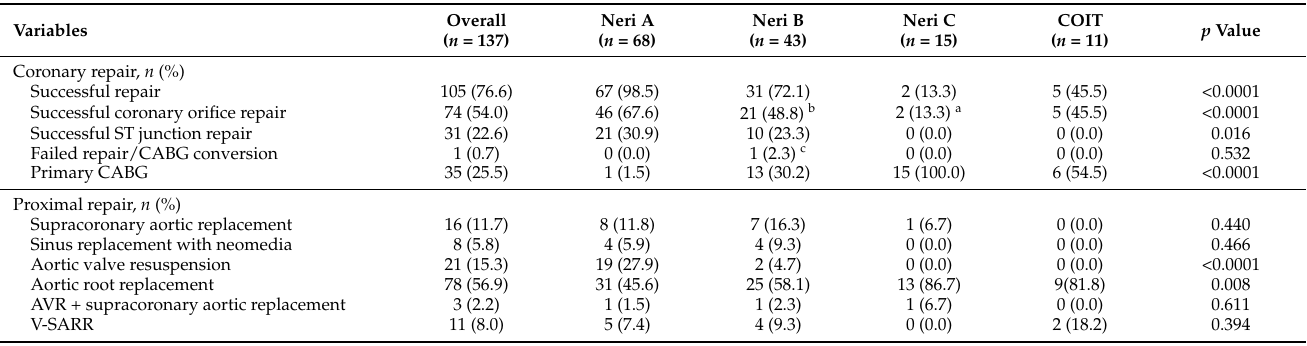
Table 5. Operative characteristics in patients with